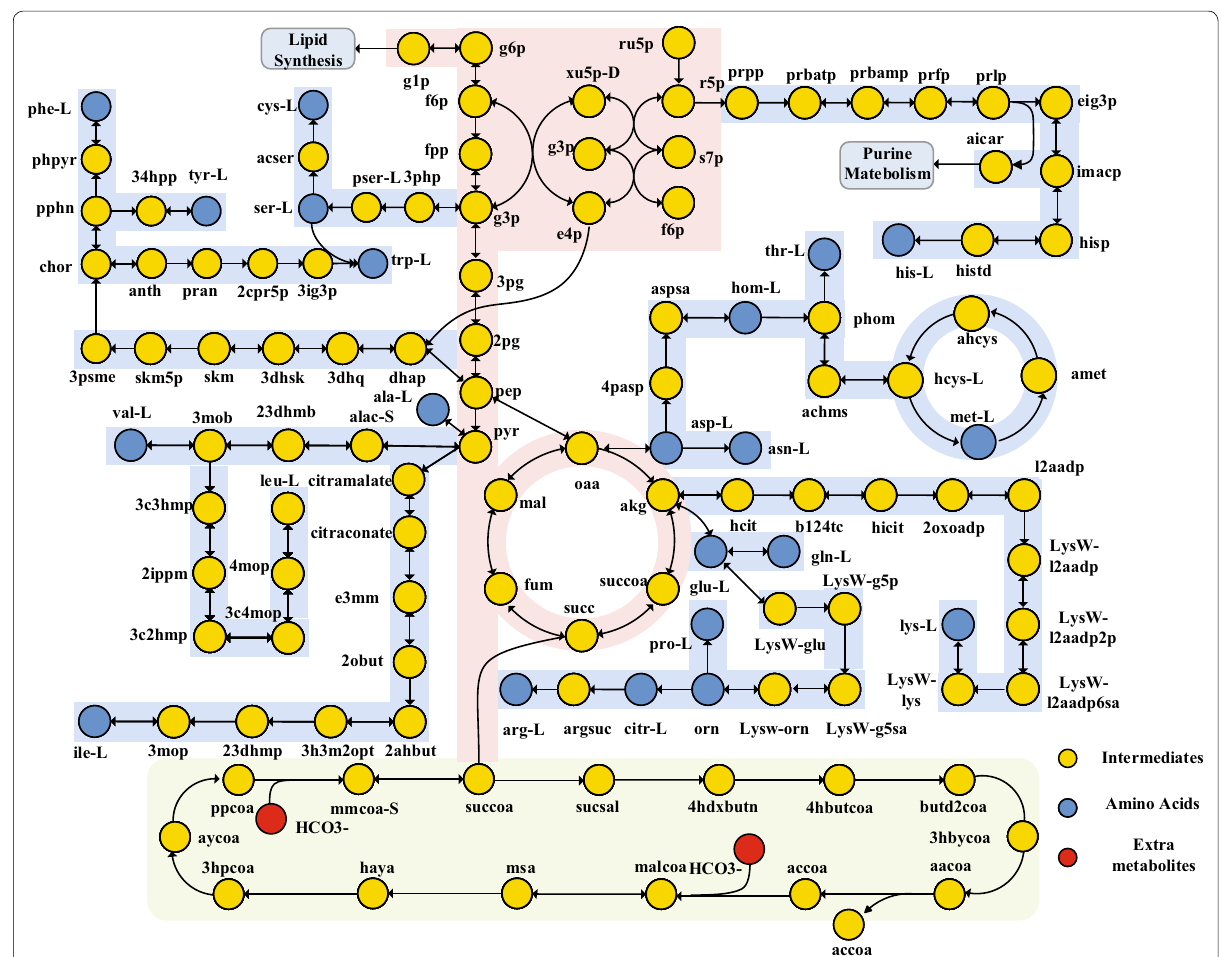
Fig. 4 Three proposed ammonia oxidation pathways in AOA. Pathway 1 was proposed by Walker et al. In this pathway, ammonia is oxidized to hydroxylamine by the membrane enzyme complex AMO/CuMMO (Walker et al. 2010). Subsequently, hydroxylamine is oxidized to nitrite in the periplasm by a heme-rich hydroxylamine oxidoreductase (CuHAO) complex. Four electrons from this oxidation are transferred to the quinone pool. Two electrons from the reduced quinone pool return to AMO (marked by red) and are required to initiate ammonia oxidation. The remaining two electrons enter the electron transport chain composed of pcy protein to generate the proton motive force (PMF) necessary for ATP synthesis and NADH synthesis. In Pathway 2 (Schleper and Nicol 2010; Stahl and de la Torre 2012), NO is speculated functioning as a redox shuttle to deliver electrons to the AMO (marked by green) since measurable amounts of NO are produced during ammonia oxidation. In pathway 3, iterative production and consumption of NO is involved in conversion of hydroxylamine to nitrite facilitated by a proposed novel copper enzyme capable of performing known P460 activity (CuP460) (Kozlowski et al. 2016). N 2 O was formed abiotically from NO by interaction with media components or with debris in killed cell. AMO/CuMMO, ammonia monooxygenase; CuHAO, hydroxylamine dehydrogenase; NIR, Cu-containing NO-forming nitrite reductase; pcy, plastocyanin; Q/QH 2 , quinone/quinol